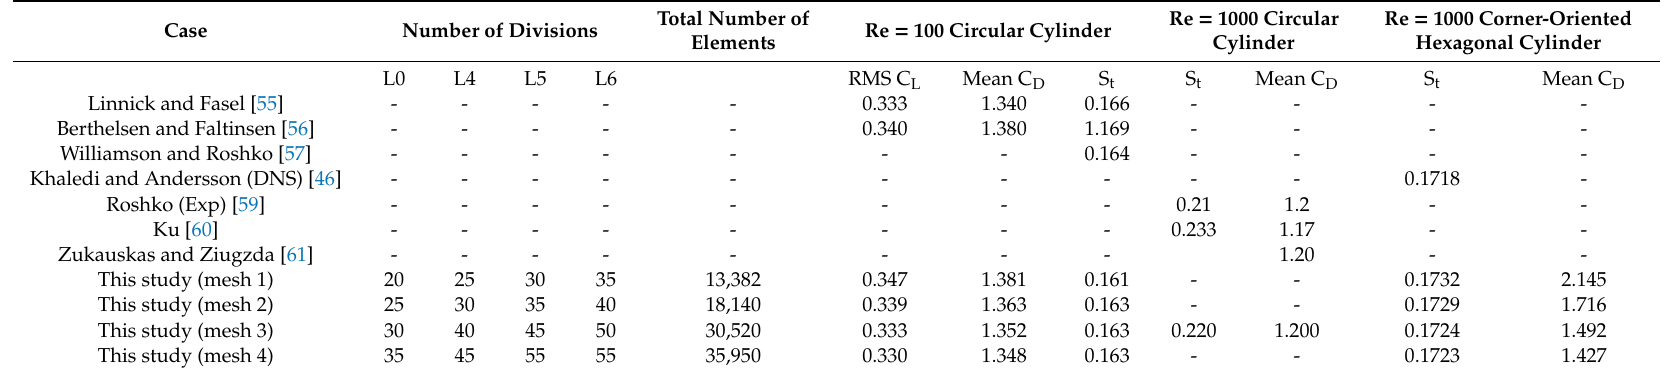
Table 1. Mesh dependence study of circular and hexagonal rigid cylinders using the computational model of Figure